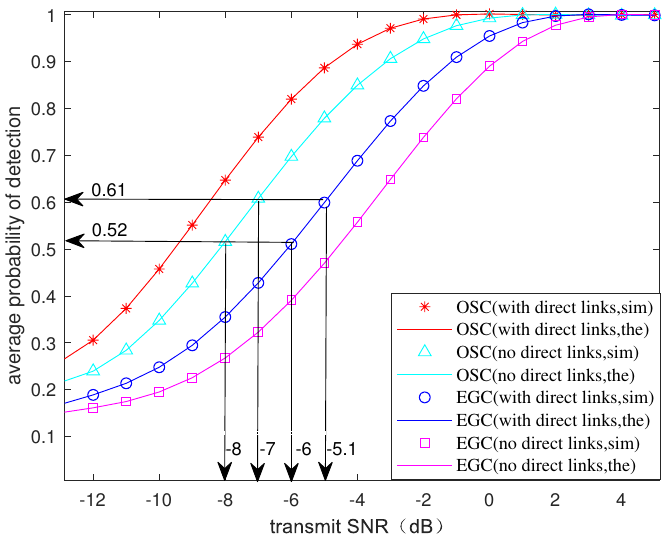
Figure 7. Average probability of detection ( P d ) versus the transmit SNR ( γ 0 ) for IRS-enhanced